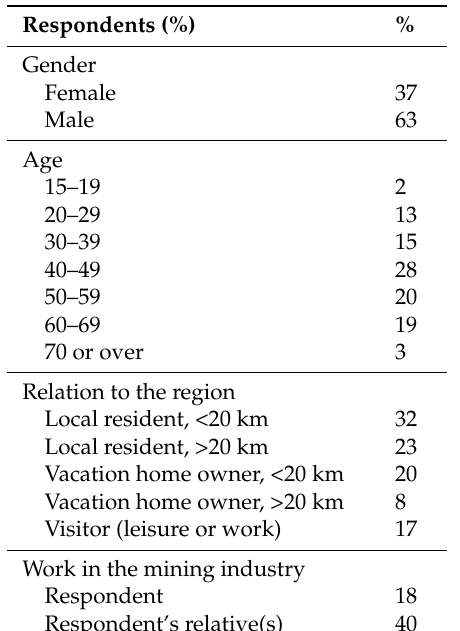
Table 1. Characteristics of respondents (n = 145) participating in the public participation